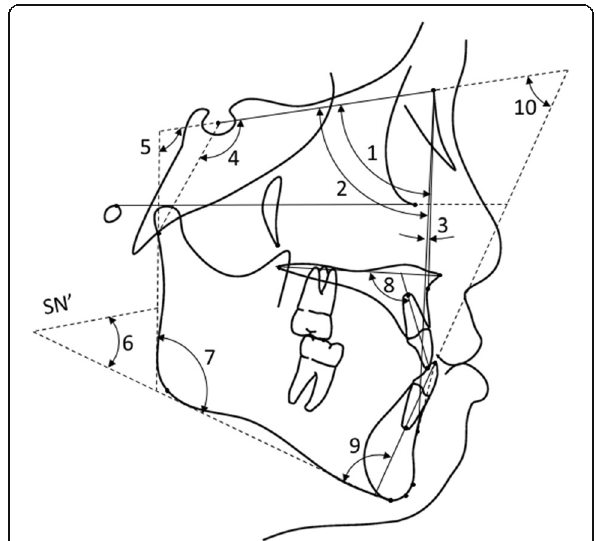
Fig. 3 Angular measurements. (1) SNA angle, (2) SNB angle, (3) ANB angle, (4) SN to SN-Ar (SN-Ar), (5) SN to ramus plane angle (SN-Rm), (6) mandibular plane angle (SN-Md), (7) gonial angle, (8) upper incisor to palatal plane angle (U1-PP), (9) incisor mandibular plane angle (IMPA), and (10) Frankfort mandibular incisor angle